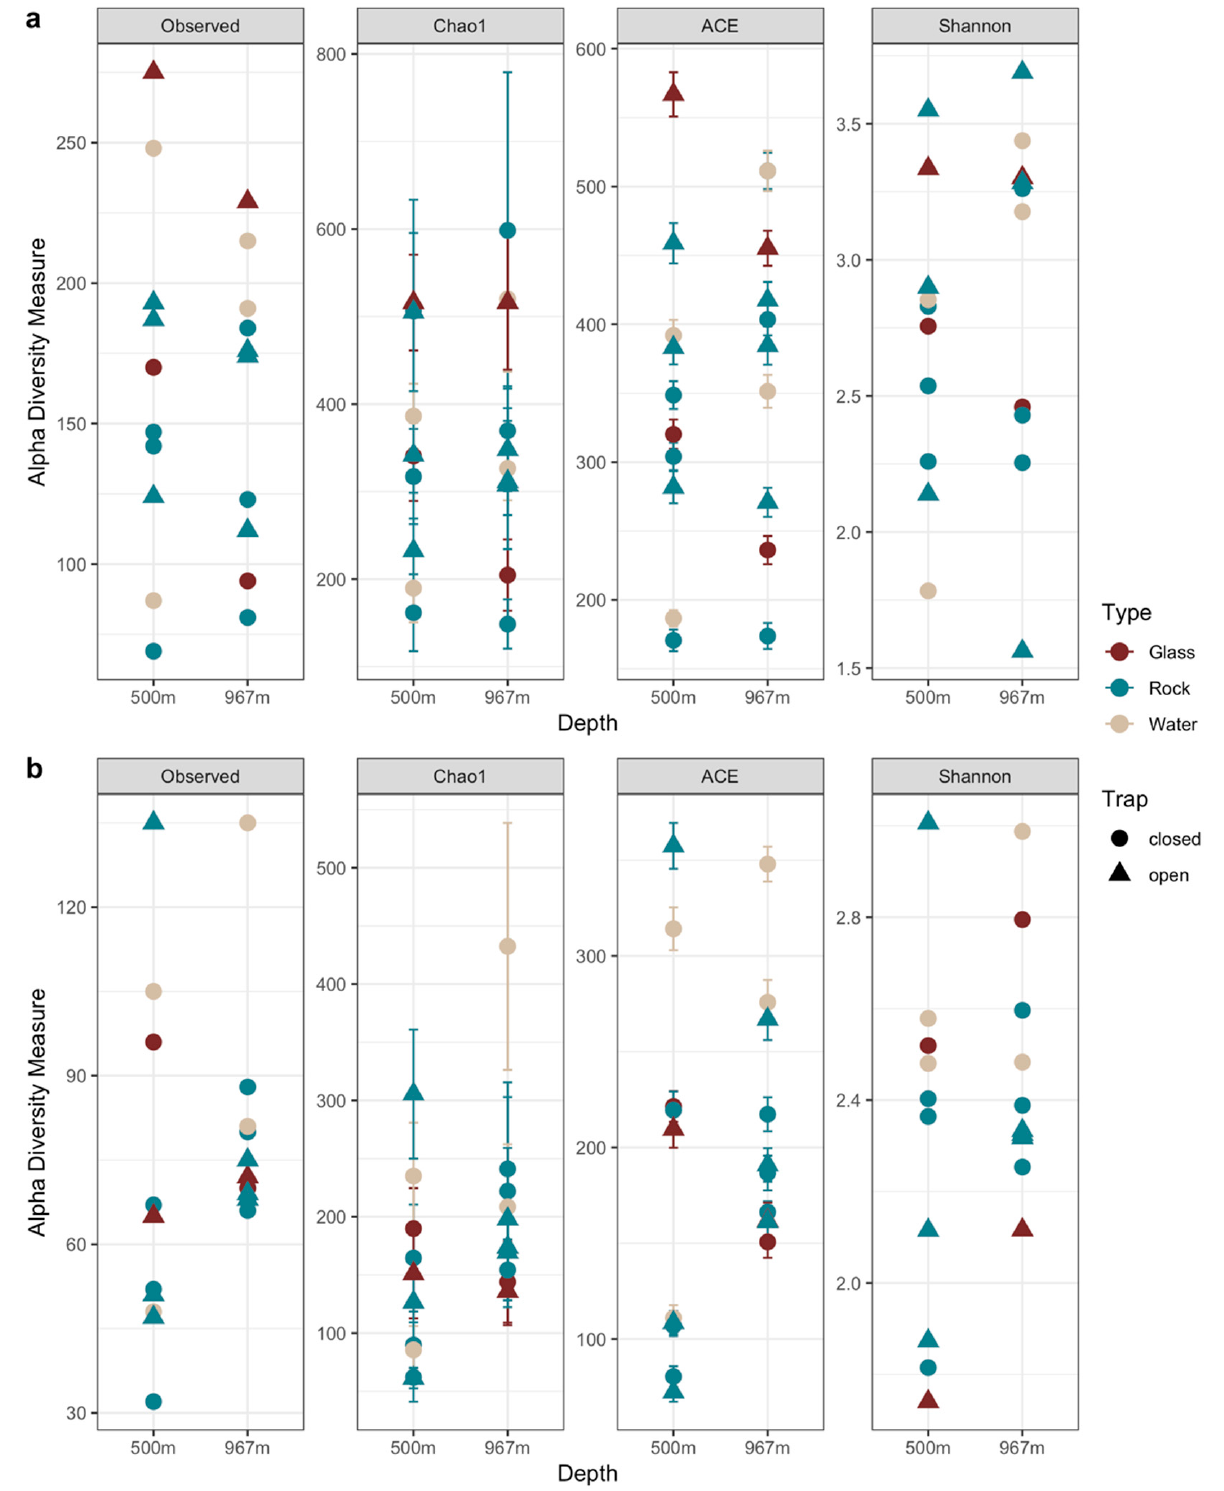
Figure 10. Alpha diversity measures of fungal ( a ) and bacterial ( b ) communities at different sampling depths. From the left, observed OTUs, Chao1 estimated number of OTUs, ACE estimated number of OTUs, Shannon’s diversity index H ′ . The error bars in the Chao1 and ACE richness graphs describe standard error (se), se.chao1, and se.ACE.